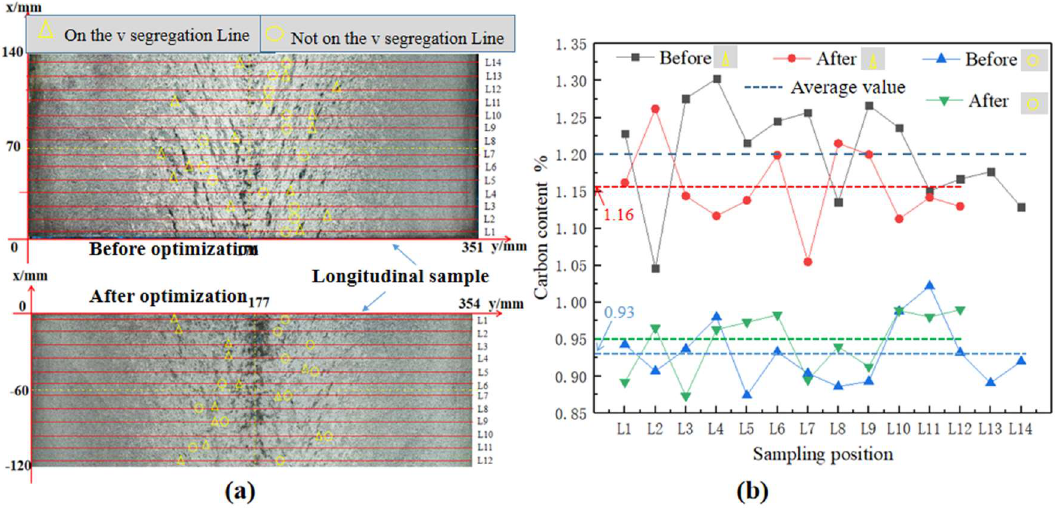
Figure 14. Schematic diagram of ( a ) sampling positions and ( b ) carbon content of different positions. The central segregation degree is represented by a carbon segregation index of the bloom center. For the bloom sample, the 30 mm flame-cutting range was removed at both ends of the sample, as shown in Figure 15a. A thin slice with a thickness of 20 mm was taken at both ends of the bloom. The center and diagonal quarter of each sample were drilled to 10 mm depth by alloy drills with a diameter of 5 mm. All the drillings were analyzed by a carbon-sulfur analyzer. The carbon segregation index is defined as 4 C/(N1 + N2 + W1 + W2), where C is the carbon content in the central position, N1, N2 and W1, W2 are the carbon content in the quarter position near the inner and outer arc diagonal, respectively. Figure 15b is the distribution of the central carbon segregation degree of bearing steel bloom. It can be seen that the central segregation degree of each condition distributes non-uniformly. Without HR optimization, the carbon segregation degree of the 1 # center of the bloom cross section is 1.23, the carbon segregation degree of the 2 # center is 1.11, and the average carbon segregation degree is 1.17. After optimized HR, the average central carbon segregation degree of the bloom cross section decreases from 1.17 to 1.15. It shows that the optimized HR can improve the central segregation of the bloom.